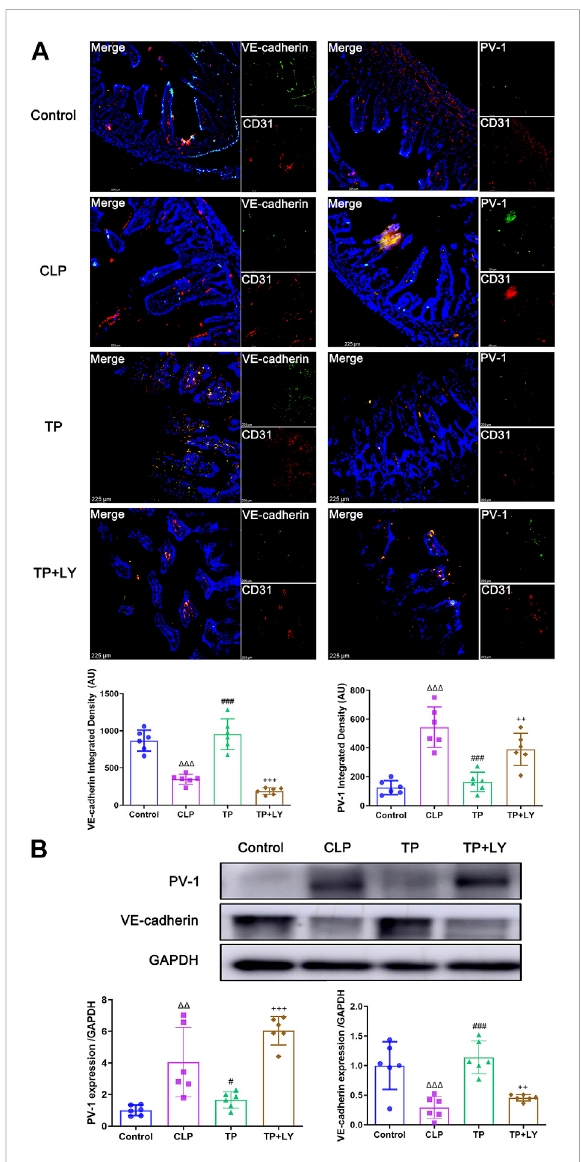
FIGURE 2 Terlipressin alleviated the GVB damage after CLP. (A) Dual immuno fl uorescence of CD31 (red) and VE-cadherin (green) or PV-1 (green) in the ileum (×200) and quantitative analysis. Nuclei were counterstained with DAPI (blue). Scale bars: 225 μ m. Quantitative analysis: integrated fl uorescence density of VE- cadherinandPV-1, n =6. (B) WesternblotofPV-1andVE-cadherin in ileum and quantitative analysis, n = 6. Data were expressed by mean ± SD. Δ p < 0.05, ΔΔ p < 0.01, ΔΔΔ p < 0.001 vs. Control group. # p < 0.05, ## p < 0.01, ### p < 0.001 vs. CLP group. + p < 0.05, ++ p < 0.01, +++ p < 0.001 vs. TP group. Figure 2A). Similarly, western blot analysis indicated that the expressions of VE-cadherin and PV-1 protein were signi fi cantly improved in the TP group (TP vs. CLP group: 1.663 ± 0.5141 vs. 4.054 ± 2.202, p = 0.0147 for PV-1 and 1.139 ± 0.2755 vs. 0.2932 ± 0.1854, p = 0.0001 for VE-cadherin; Figure 2B).